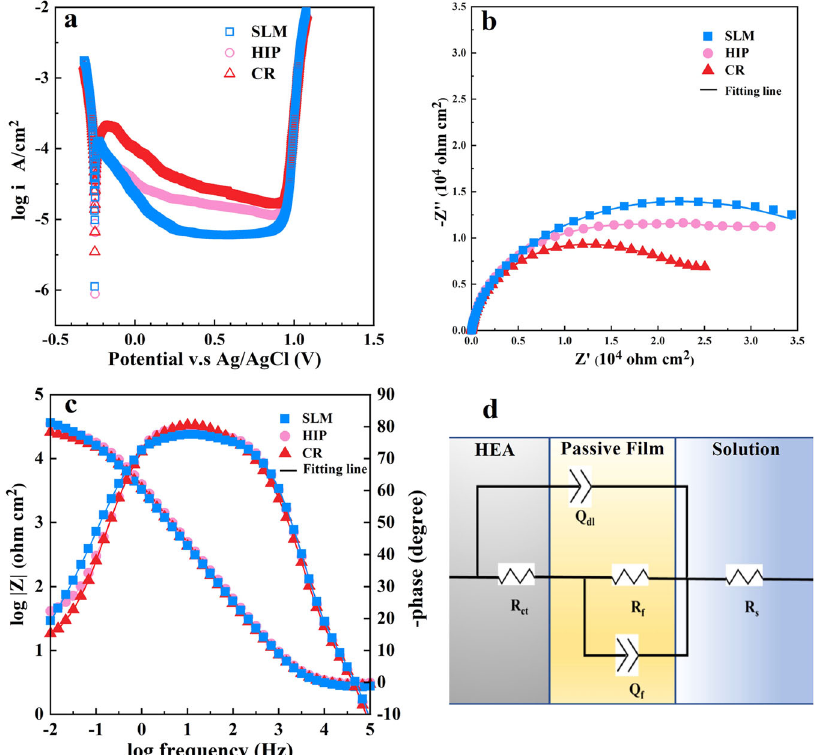
Fig. 2 Electrochemical measurements of the CoCrFeNiN 0.07 HEAs. a Potentiodynamic polarization curves, b Nyquist plots, c Bode plots, and d the equivalent circuit of the SLM, HIP, and CR HEAs at room temperature (RT) in 0.5 M H 2 SO 4